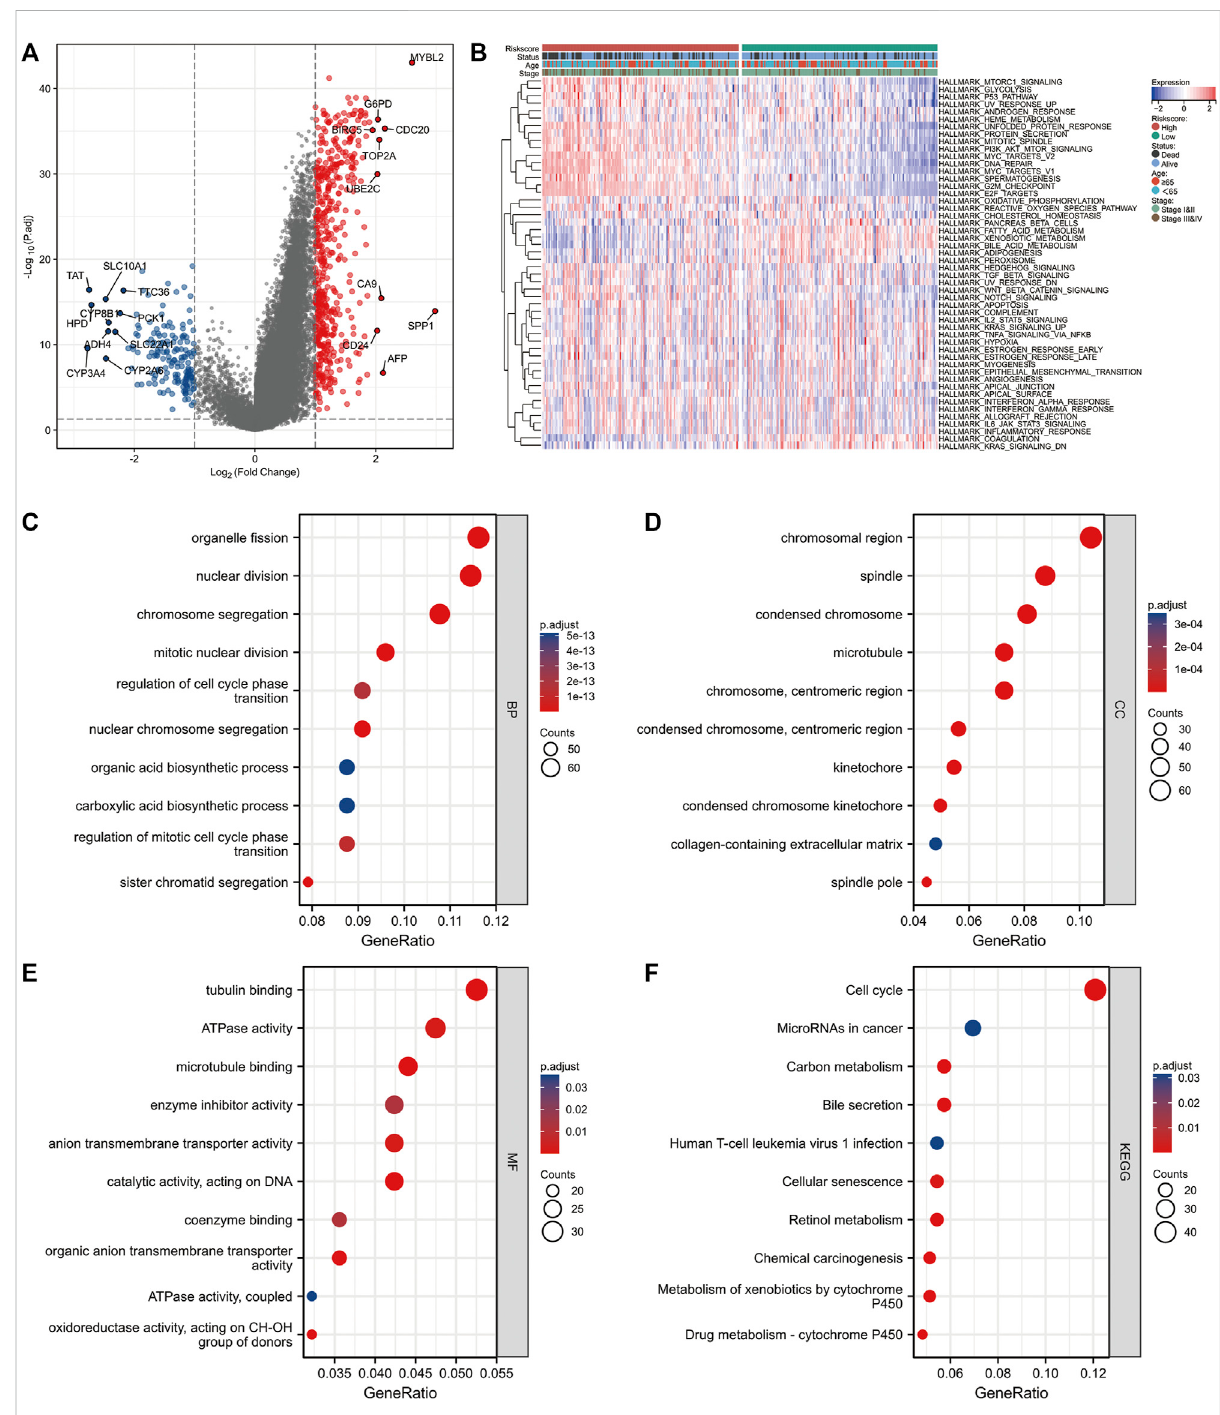
FIGURE 4 Differences in molecular mechanisms between patients in high and low NMRS groups. (A) The “ limma ” package was used to identify DEGs in high and low NMRS groups, with up-regulated genes in red and down-regulated genes in blue. (B) GSVA enrichment analysis was applied to identify differences in activity between patients in high and low NMRS groups on the Hallmark gene sets. (C – E) GO enrichment analysis of DEGs. (F) KEGG enrichment analysis of